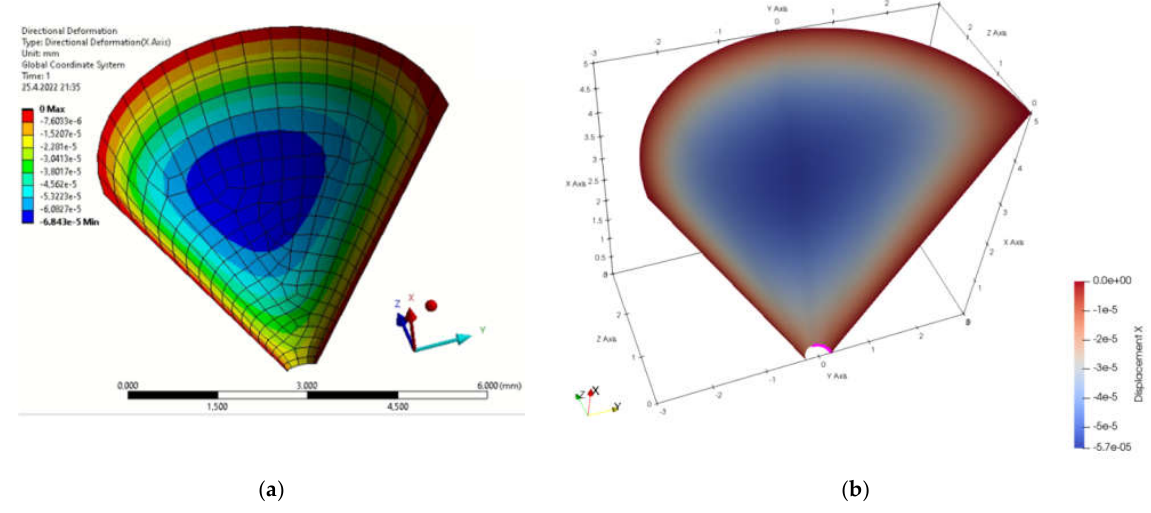
Figure 5. Geometric characteristics, boundary conditions and material properties ( a ) FEM program; ( b ) MATLAB.